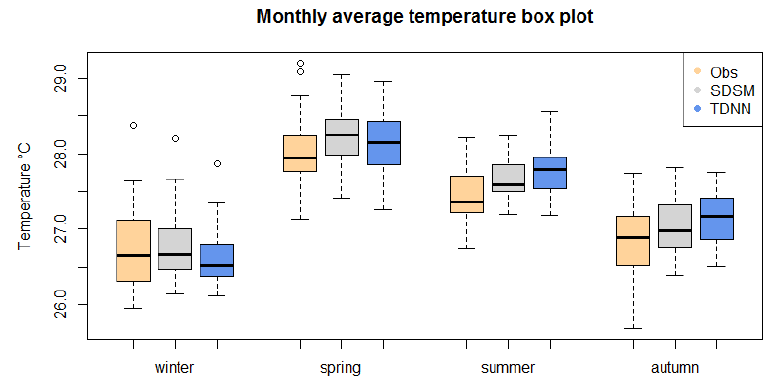
Figure 5. Average temperature box plot.